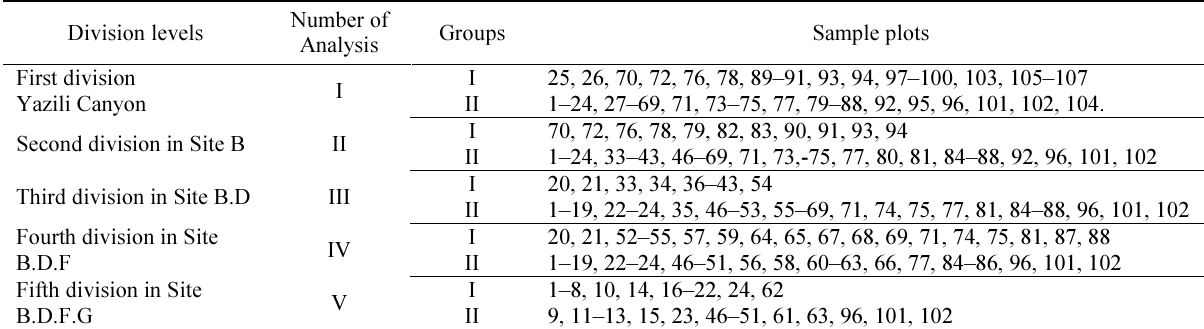
Table 2. Determined groups of sample plots (mapping units) Division level Determined groups Sample